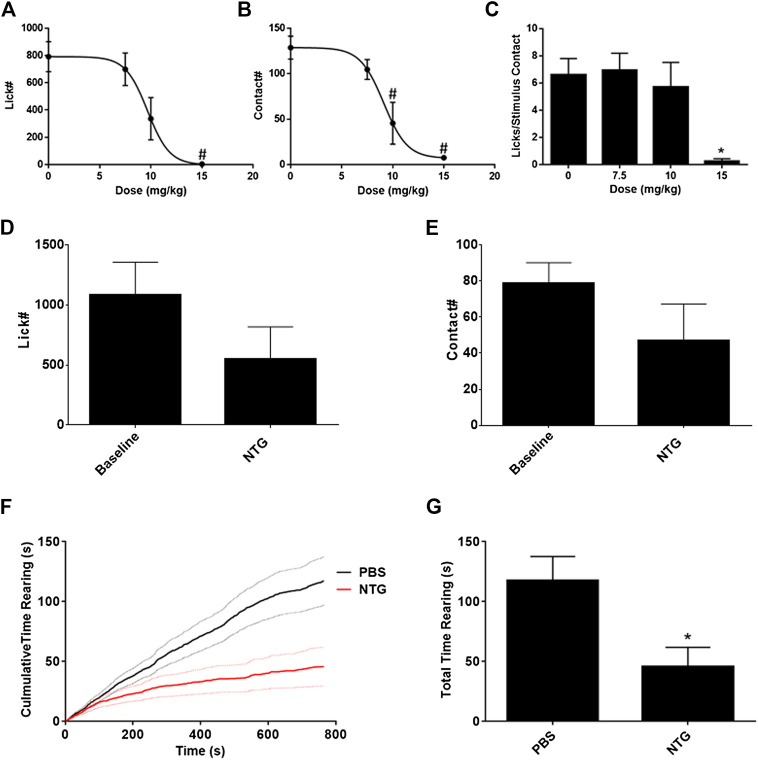
Effect of nitroglycerin on rat behavior. (A) Nitroglycerin dose response relationship on reward bottle licking in the OPAD assay. ED50 = 9.68 ± 1.00 mg/kg, One-way ANOVA: F (3, 56) = 6.79, p = 0.0006. #p < 0.05 Dunnett’s test when compared to 0 mg/kg. (B) Nitroglycerin dose response relationship on stimulus contacts in the OPAD assay. ED50 = 9.11 ± 0.85 mg/kg, One-way ANOVA: F (3, 56) = 12.99, p < 0.0001. #p < 0.05 Dunnett’s test when compared to 0 mg/kg. (C) Nitroglycerin dose response relationship on the ratio of lick to stimulus contacts in the OPAD assay. One-way ANOVA: F (3, 54) = 3.490, p = 0.0217. *p < 0.05 Holm-Sidak's multiple comparisons test when compared to 0 mg/kg. (D) Effect of nitroglycerin (10 mg/kg, i.p.) on licking in the OPAD assay 4 h following injection. (N = 7, Baseline vs NTG paired t-test: t = 1.812 df = 6, p = 0.120). (E) Effect of nitroglycerin on stimulus contacts in the OPAD assay 4 h following injection. (N = 7, Baseline vs. NTG paired t-test: t = 1.580 df = 6, p = 0.165). (F) Effect of nitroglycerin (10 mg/kg, i.p.) in the rearing behavioral assay (N = 14 nitroglycerin, N = 15 PBS). Dashed lines are standard errors for the curves. (G) Nitroglycerin reduces total time rearing. * t-test: t = 2.758 df = 27, p = 0.010.